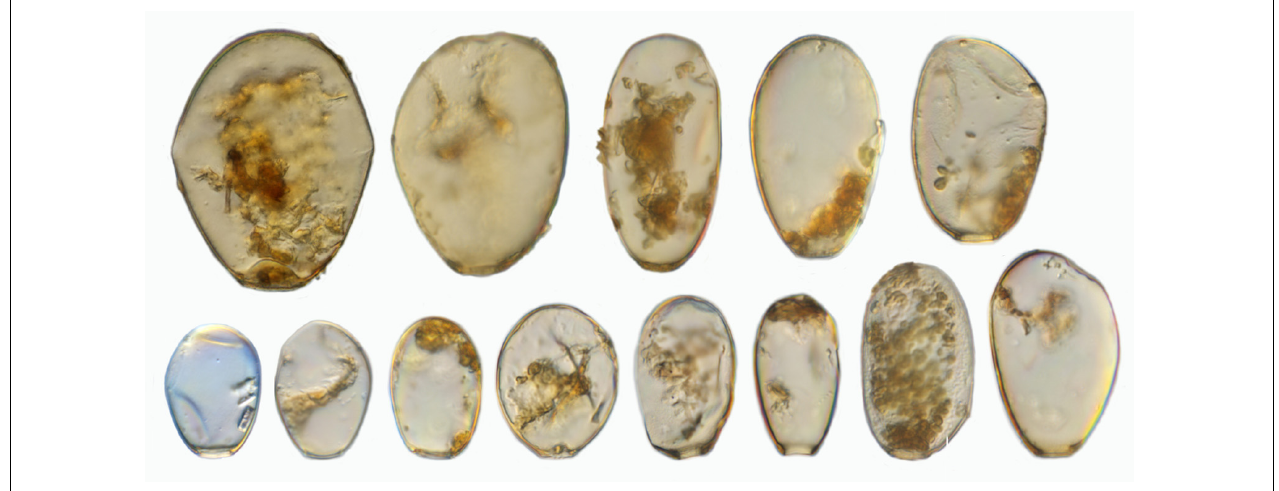
FIGURE 7 | Examples of different Hyalopshenia subflava morphotypes with a shell length of 40 to 105 µ m from one location (NS13). Image by F.